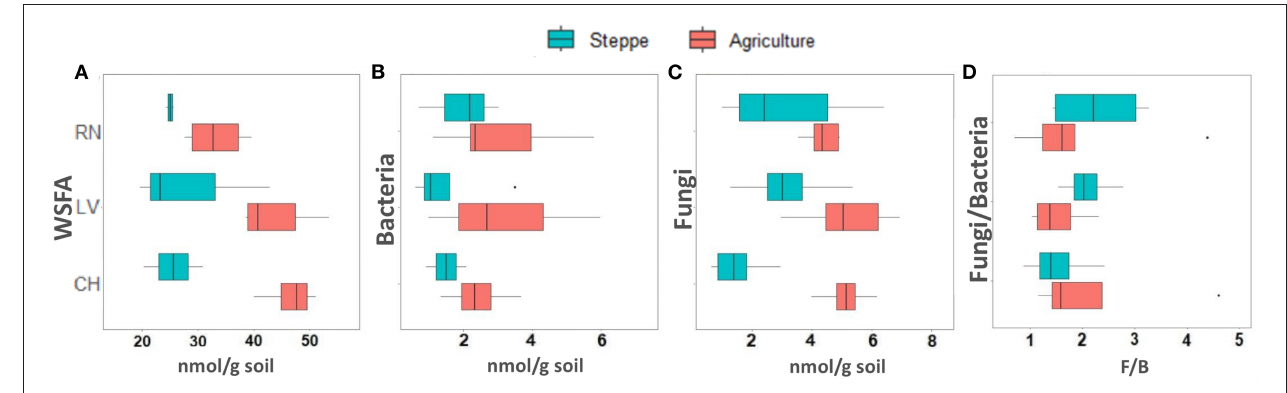
FIGURE 2 | Boxplots showing (A) total WSFA, (B) total bacteria, (C) total fungi, and (D) fungi-bacteria ratio estimated from WSFA.